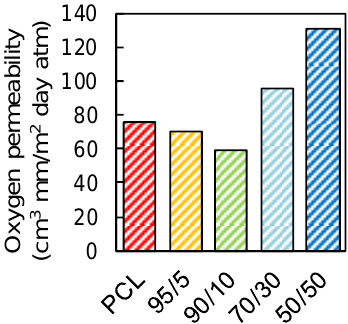
Figure 7. Oxygen transmission rate of neat PCL and PCL / PFA blends in 95 / 5, 90 / 10, 70 / 30 and 50 / 50 proportions.